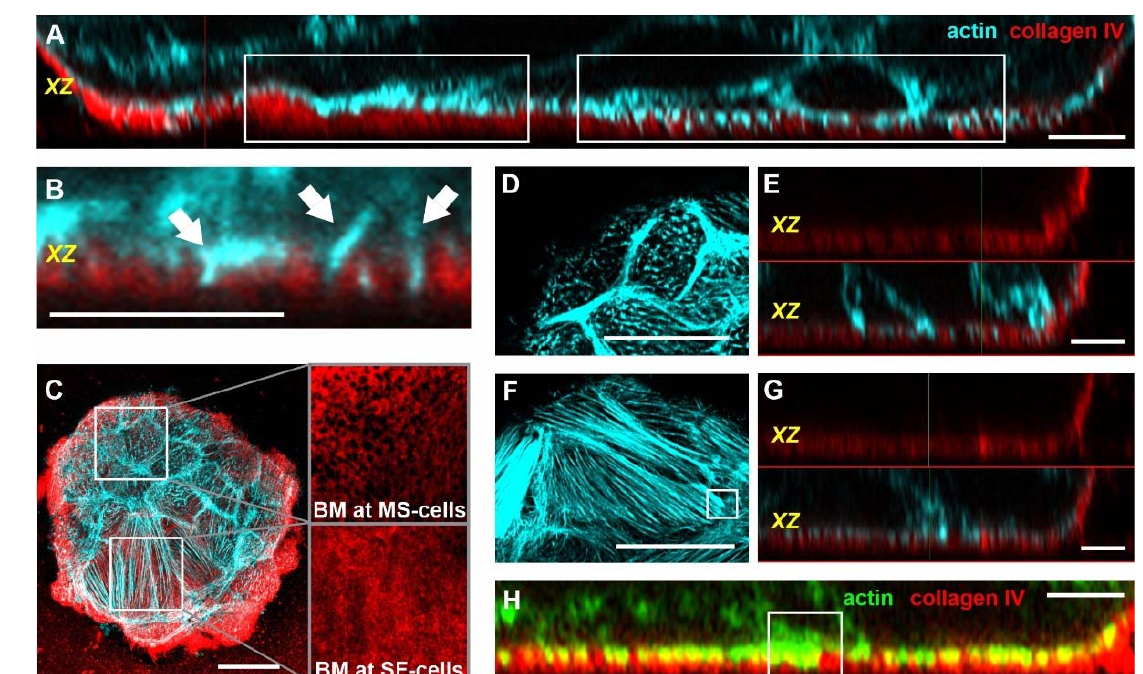
Figure 5. The actin cytoskeleton intercalates with the BM scaffold. Pre-invasive MCF10A acini were fixed and IF-stained. ( A ) The orthogonal projection of the basal cell layer that is in direct contact with the underlying substrate (not visible) highlights the connections between actin (cyan) and the BM (collagen IV, red). Left box: F-actin located on top of collagen IV network. Right box: F-actin penetrating the collagen IV network. ( B ) The micrograph shows BM traversing microspikes (white arrows) in an MS cell of an EGF triggered ld-BM acinus (7 h on glass). ( C ) Overview image of the acinus–BM–substrate interface shows different BM porosity beneath MS cells (upper box) and SF cells (lower box) (ld-BM, 1 h on glass, –EGF) (same sample analyzed as in Figure 4C) ( D ) Acinus with MS cells (ld-BM, 1 h on glass, –EGF). ( E ) The orthogonal projection of MS cells shows actin-rich microspikes penetrating the BM collagen IV scaffold. ( F ) Acinus with SF cells (ld-BM, 24 h on glass, +EGF). ( G ) The orthogonal projection of SF cells shows actin stress fibers ends at the top of the collagen IV network without detectable penetration. ( H ) The orthogonal projection of an SF cell highlights a BM-penetrating stress fiber-tip (cf. box in ( F )). Scale bars: ( C , D , F ) = 20 μ m, others = 5 μ m.